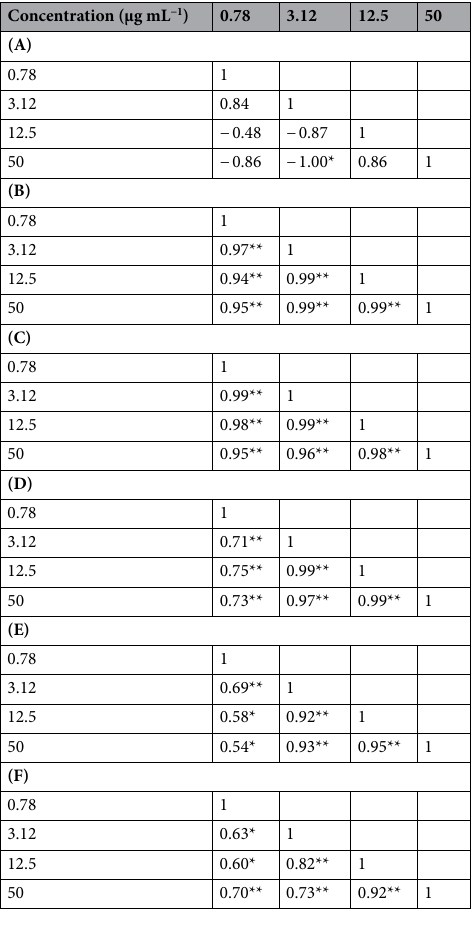
Table 5. Correlation of the antioxidant activity of spinasterol and 22,23-dihydrospinasterol versus antifungal and insecticidal activities. A, antioxidant activity. B, antifungal activity against M. grisea . C, antifungal activity against R. solani . D, antifungal activity against Phytophthora . E, insecticidal activity in residual assay; F, insecticidal activity in greenhouse assay. * P < 0.05, ** P < 0.01, significant Pearson’s correlation